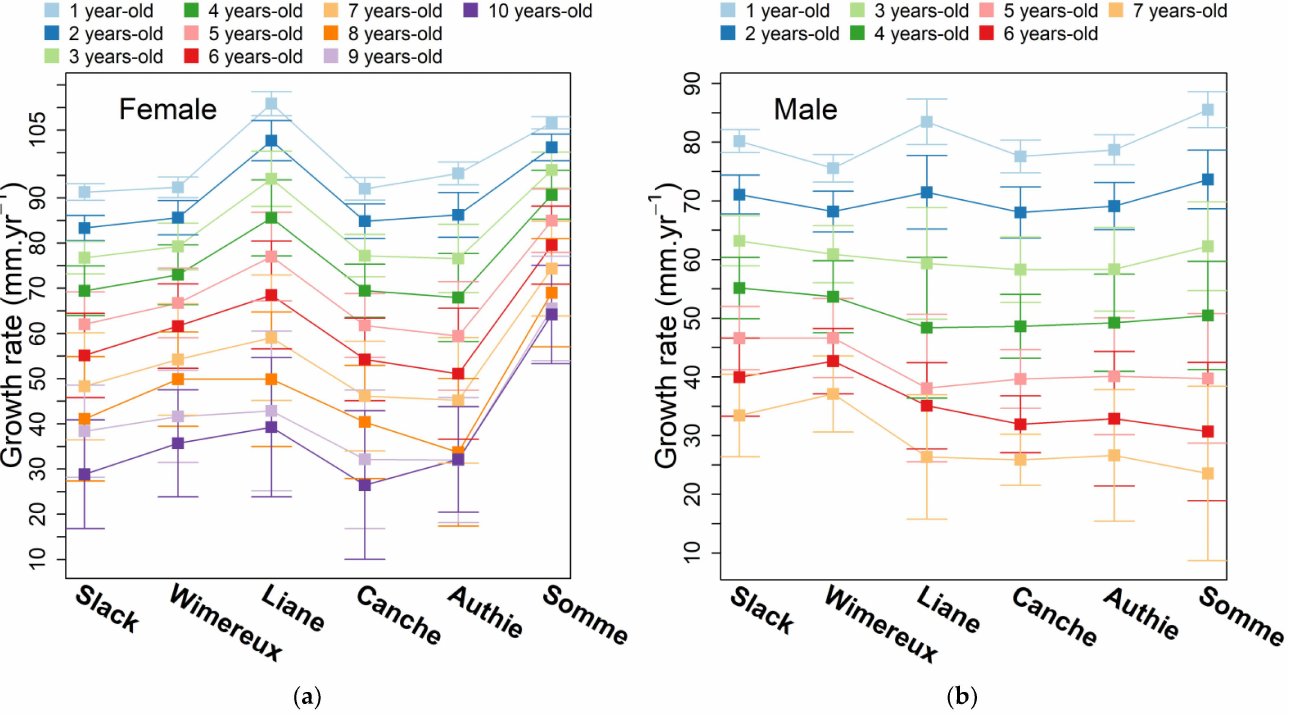
Figure 5. Annual growth increments (mm · yr − 1 ) ± standard deviation from ( a ) 1 to 10 years-old female eels and ( b ) from 1 to 7 years-old male eels collected in the six estuaries. Table 3. p -values of Tukey multiple comparisons tests on the estuary effects on annual growth increments of female and male eels collected in the six